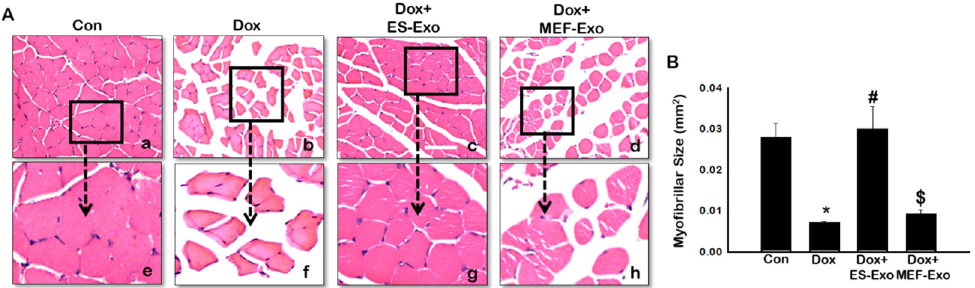
Figure 12. ES-Exos treatment protects the soleus muscle from Dox-induced atrophy. ( A ) Representative images of hematoxylin and eosin (H&E) stained transverse soleus tissue are shown. Each box shows Control ( a ), Dox ( b ), Dox + ES-Exo ( c ), Dox + MEF-Exo ( d ), and enlarged images ( e – h ) for each group respectively. ( B ) Quantitative analysis for muscle atrophy. Error bars = mean ± S.E.M. * p < 0.05 vs. control, # p < 0.05 vs. Dox, $ p = non-significant vs. Dox, one-way ANOVA followed by Tukey test; Scale bar = 100 µm, n = 14–16 (male and female). Images taken at 40 × magnification.